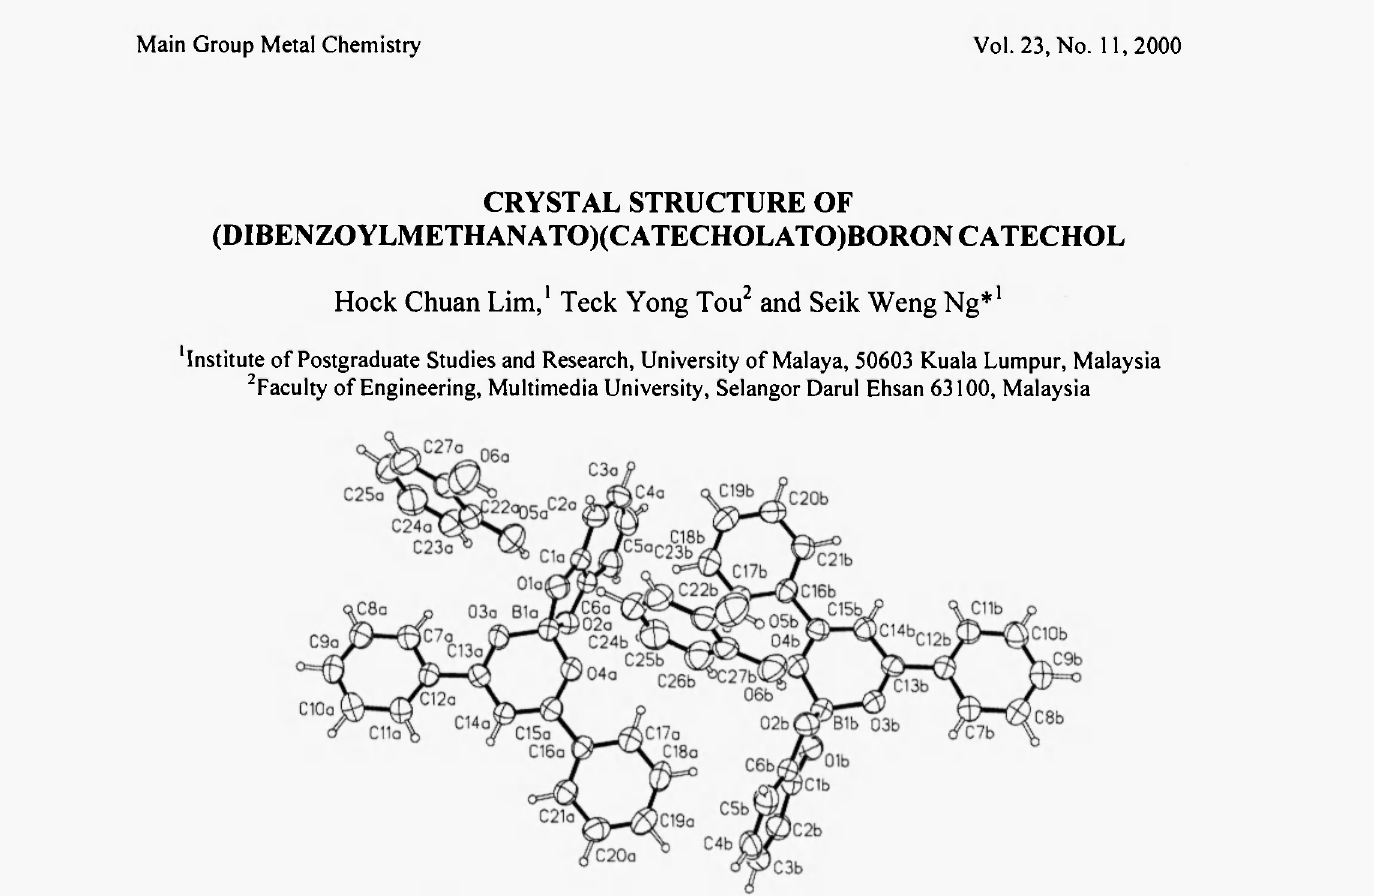
Figure 1. ORTEP plot of (dibenzoylmethanato)(catecholato)boron catechol. Selected bond distances and angles: ΟΙα-ΒΙα = 1.472(3), 02α-Β1α = 1.462(3), 03α-ΒΙα = 1.484(3), 04α-Β1α = 1.489(3), 05α Οία = 2.749(2), 06α 05α = 2.700(3), O l i - B li = 1.458(3), 02b-B\b = 1.468(3), 036-Β16 = 1.488(3), 046-Β16